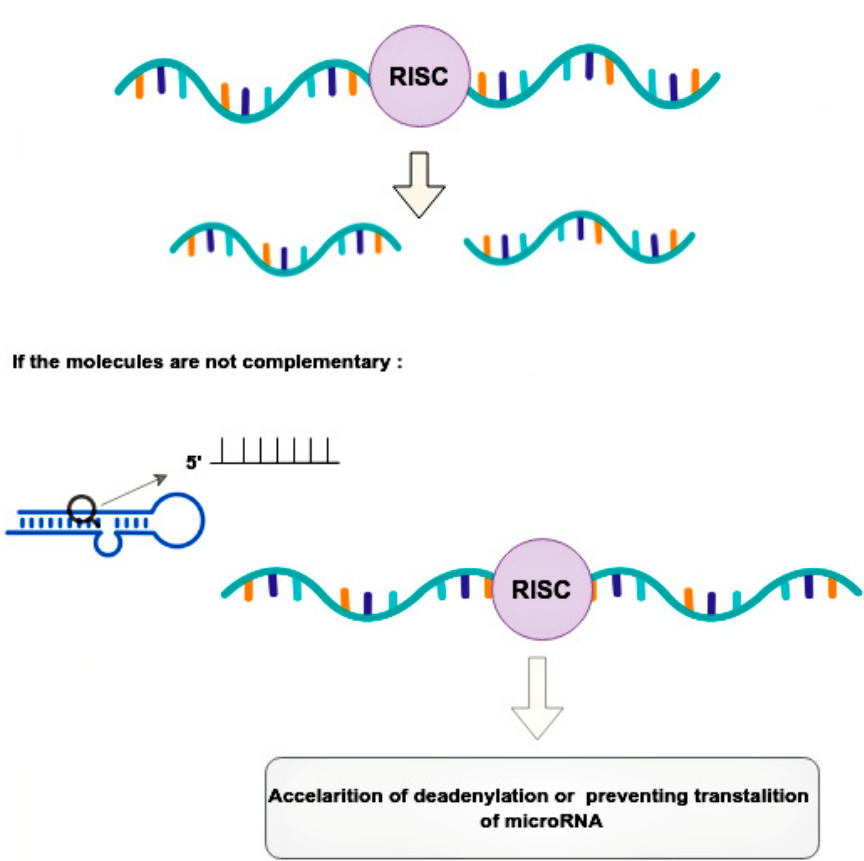
Figure 2. Regulatory patterns of mRNA and microRNA interaction. MicroRNAs bind to the mRNA MRE complex in 3’-untranslated regions, resulting in the post-transcriptional silencing of genes. The mode of silencing in RISC depends whenever mRNA and microRNA are completely or partially complementary. In cases where molecules are perfectly complementary, the RISC simply cleaves the target mRNA. In cases where molecules are no perfectly complementary, the RISC binds to the MRE only by the heptameric 5’seed region of the guide microRNA, leading to acceleration of mRNA decay. This happens due to deadenylation or interruption translation at its different stages. RISC—the RNA-induced silencing complex, MRE—microRNA response